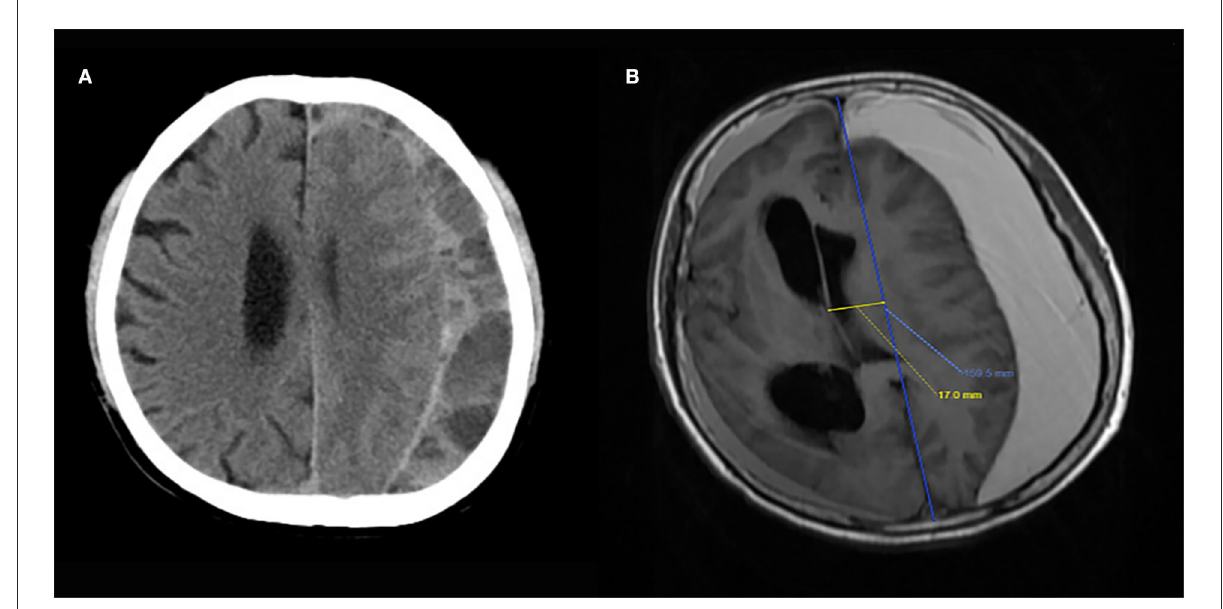
FIGURE1 Image examples of the key features of presence of septation (A) and basal ganglia compression (B) .